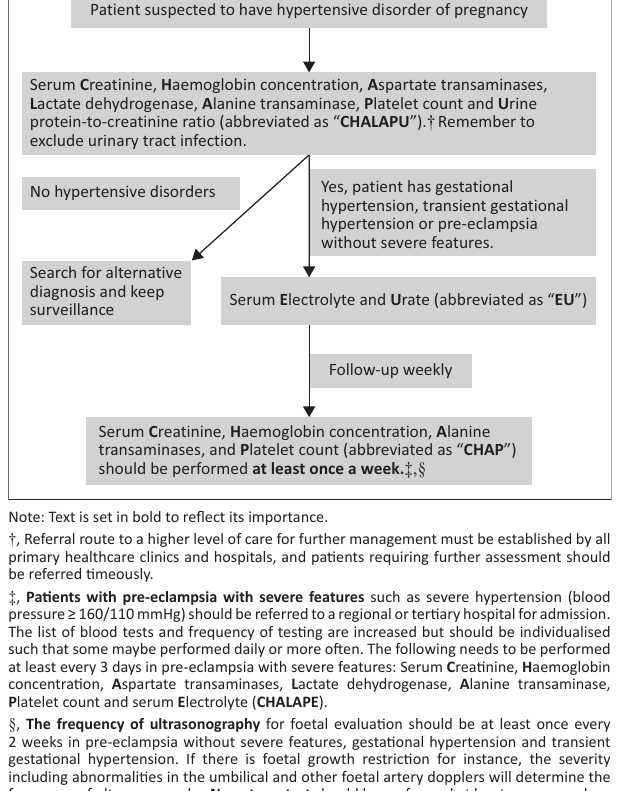
FIGURE 1: Minimum laboratory tests for a suspected hypertensive disorder of pregnancy and stringent monitoring of gestational hypertension, transient gestational hypertension and pre-eclampsia without severe